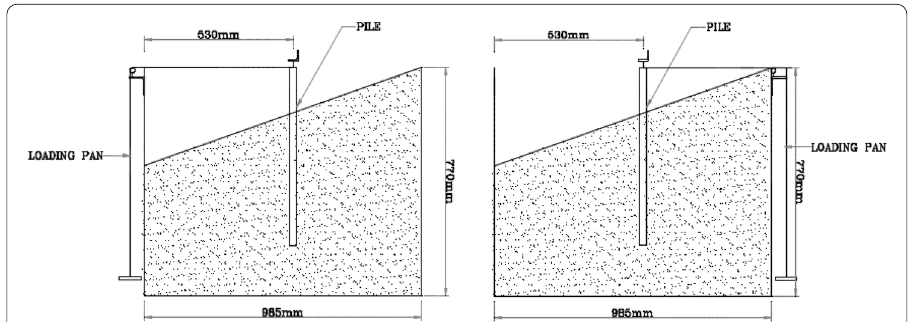
Fig. 7 Schematic representation of test set-up for pull along and against sloping (1V: 3H) ground